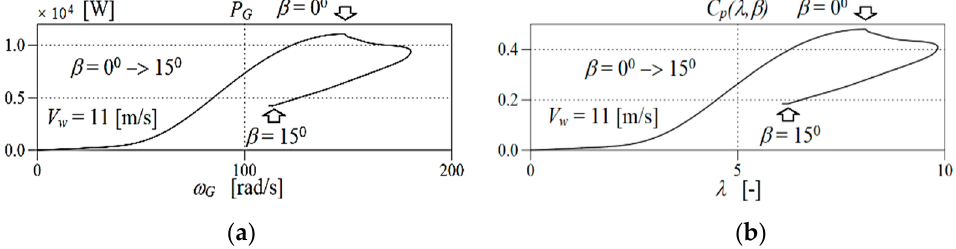
Figure 15. Waveforms of generator power P G ( a ) and turbine power coefficient C p ( λ , β ) ( b ) for constant wind speed and blade setting angle β changing from 0 ◦ to 15 ◦ .